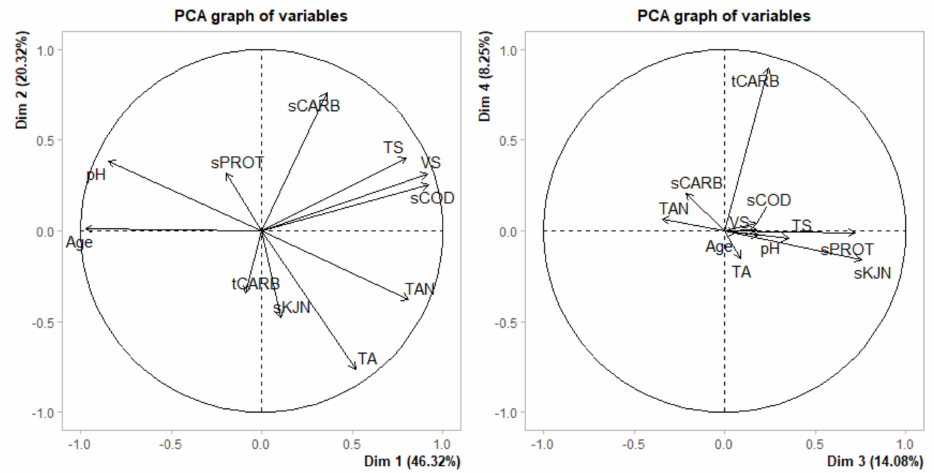
Figure 3. PCA biplot depicting the interdependencies of the biochemical parameters during US dis-